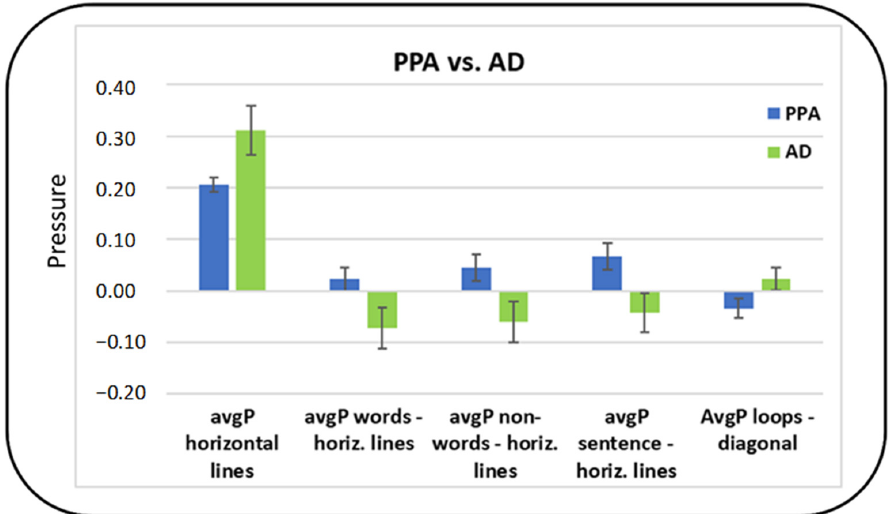
Figure 3 . Differences in average and maximum writing pressure between patients with PPA and patients with AD .